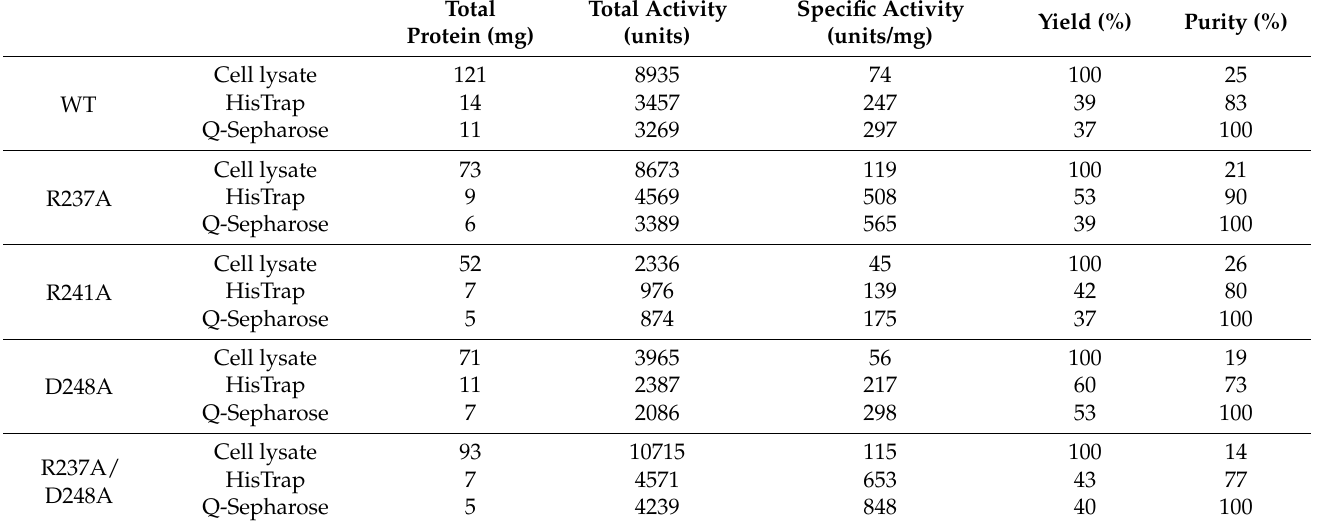
Table 1. Purification summary of the WT and mutant PML enzymes.